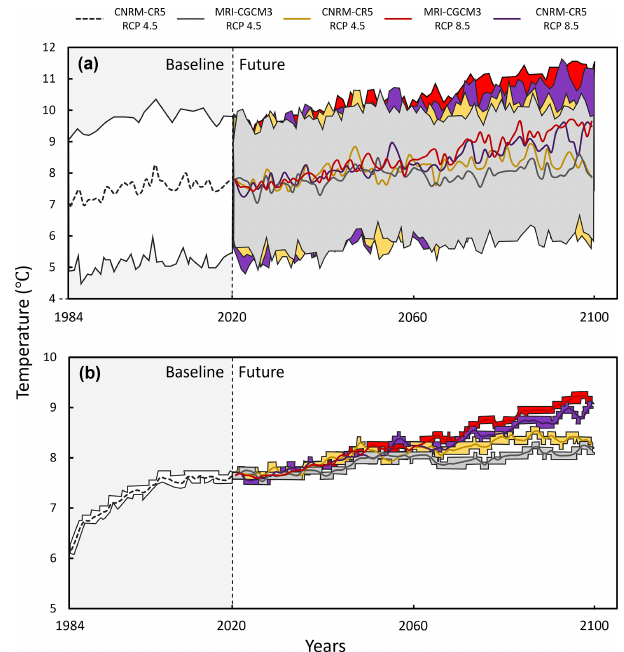
Figure 10. Modelled 365d averaged subsurface temperatures (lines) and their associated intra-annual range (area) at two depths: (a) 4.2m and (b) 13.9m (representing the groundwater temperature sensor depths in our piezometer and the provincial monitoring well, respectively). The historical period (1984–2020) uses the CNRM- CR5 simulation data, and four future simulations were run for the period of 2020–2100. The beginning of the historical simulation in- volves a period of model domain